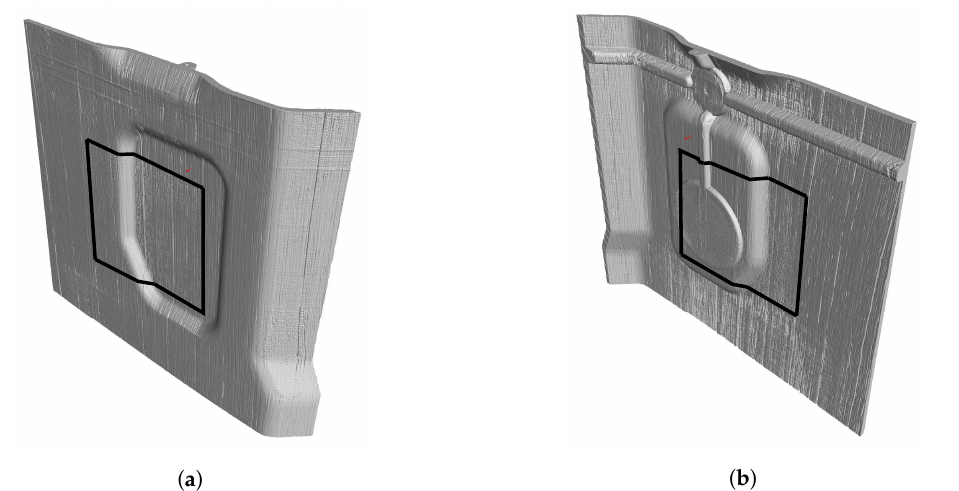
Figure 5. 3D view of the test specimen: ( a ) front and ( b ) rear side. The voxel size of the measurement was 80 µ m; for the area indicated by the black rectangle a voxel size of 30 µ m was